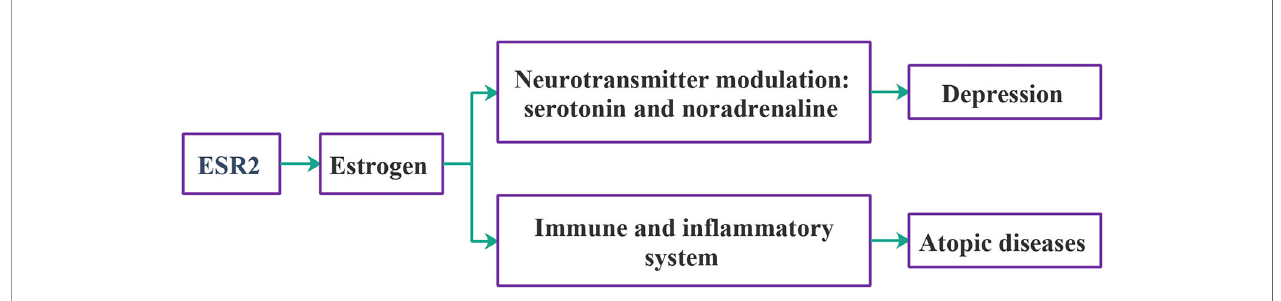
FIGURE 4 | Schematic relationships of ESR2 with depression